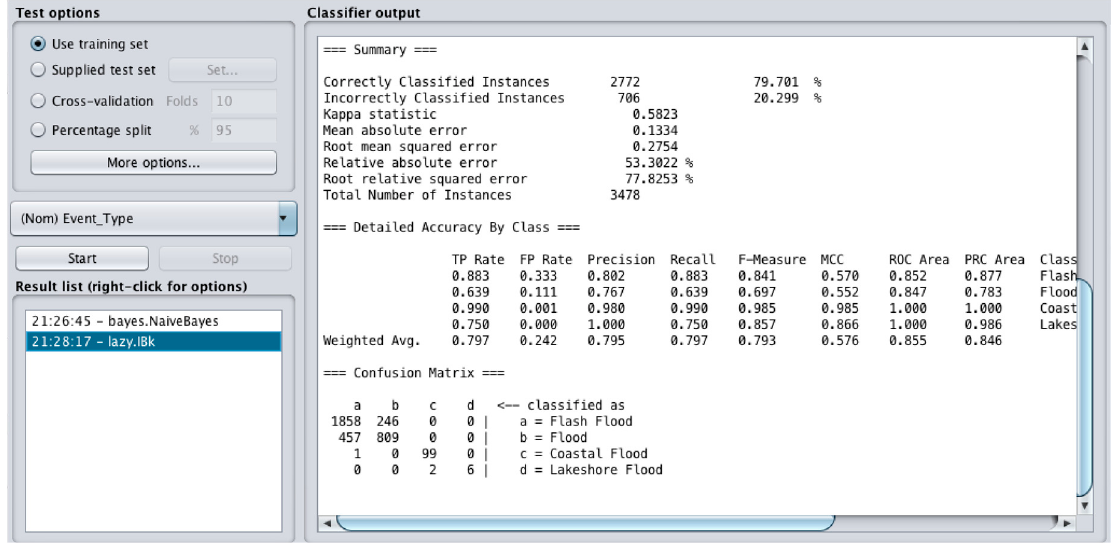
Figure 8. Evaluation Results for Lazy model in Weka.